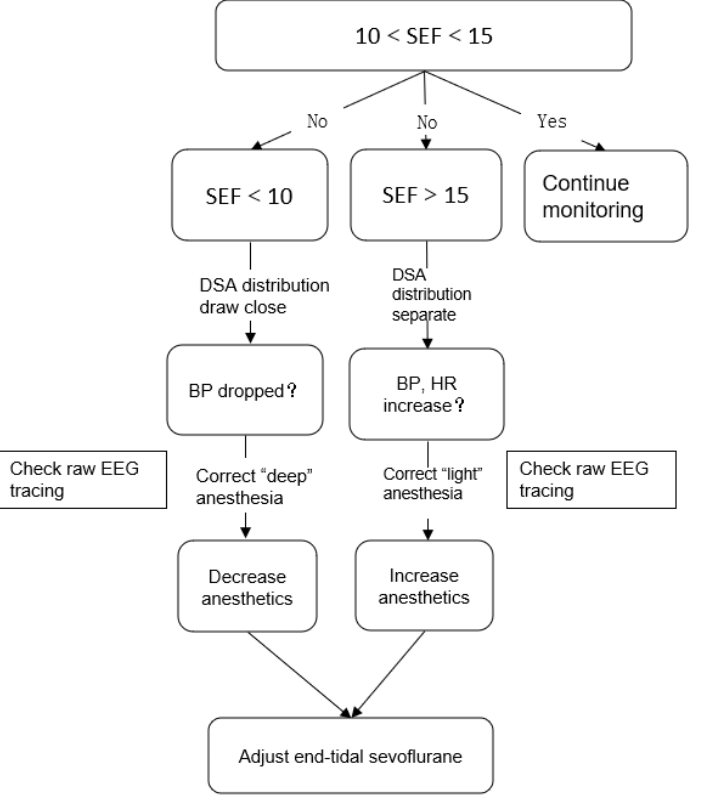
Figure 3. Intervention flow diagram. SEF, spectral edge frequency; BP, blood pressure; HR, heart rate; EEG, electroencephalography.